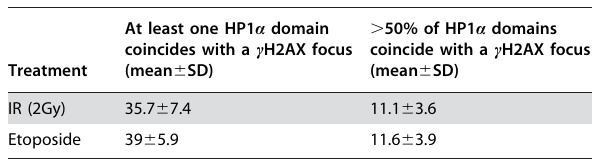
Table 1. Distribution of c H2AX foci in relation to HP1 a staining in MCF7 cells treated with DNA damaging agents. .. ... .... ... ... .... ... ... .... ... ... .... ... ... .... ... ... .... ... ... .... .